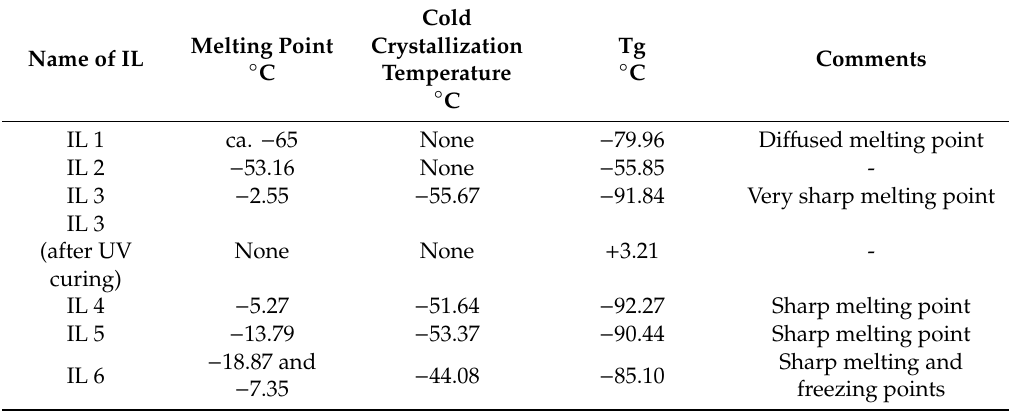
Table 2. Melting points, cold crystallization temperatures, and glass transition temperatures (Tgs) of ILs applied in the study. Names of ILs correspond to numbers in Table 1.